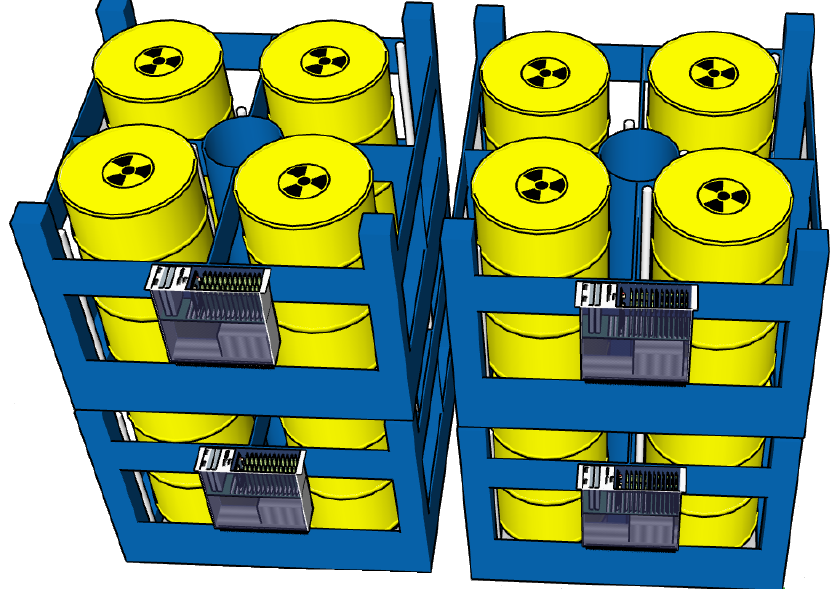
Figure 1. A possible arrangement of radwaste packages where monitor sensors are installed.